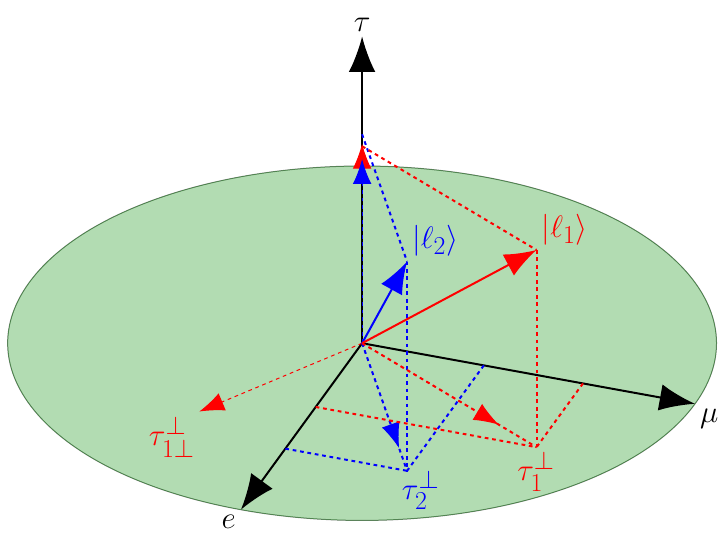
Figure 4 . Ilustration of the two (cid:13)avour regime for two RH neutrino